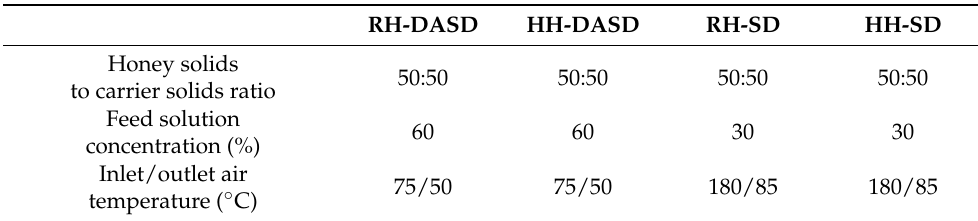
Table 1. Experimental variants during traditional spray drying (SD) and dehumidified air